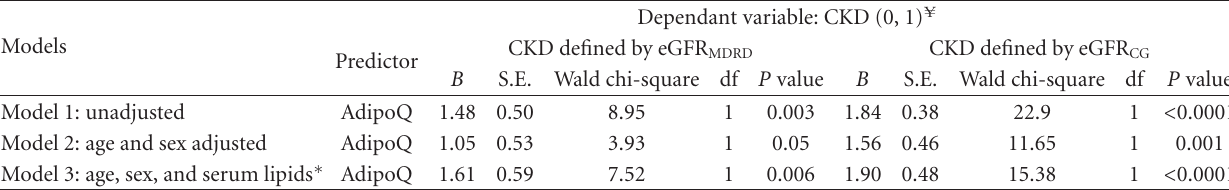
Table 4: Association between moderate CKD and adiponectin levels in non-diabetic West Africans using logistic regression models.